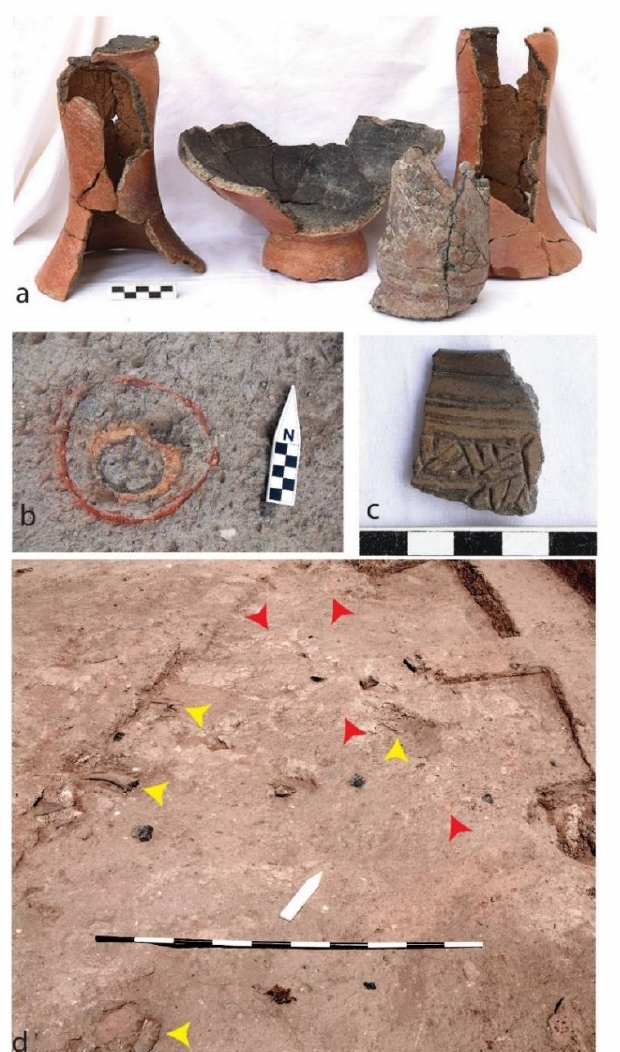
Figure 8. Examples of items found in votive/foundation deposits: ( a ) “fruitstands”; ( b ) example of ochre deposits (inner deposit is burnt) incorporated into mudbrick at the base of an architectural feature; ( c ) incised/decorated sherds; ( d ) the large deposit (only partially excavated here) found on a courtyard floor onto which an entire wall was pushed: yellow arrows indicate some of the numerous animal horns and bones laid on the plaster floor of the courtyard, and red arrows indicate lumps or smears of ochre. The black items are either lumps of obsidian or large sherds intentionally laid on the floor.